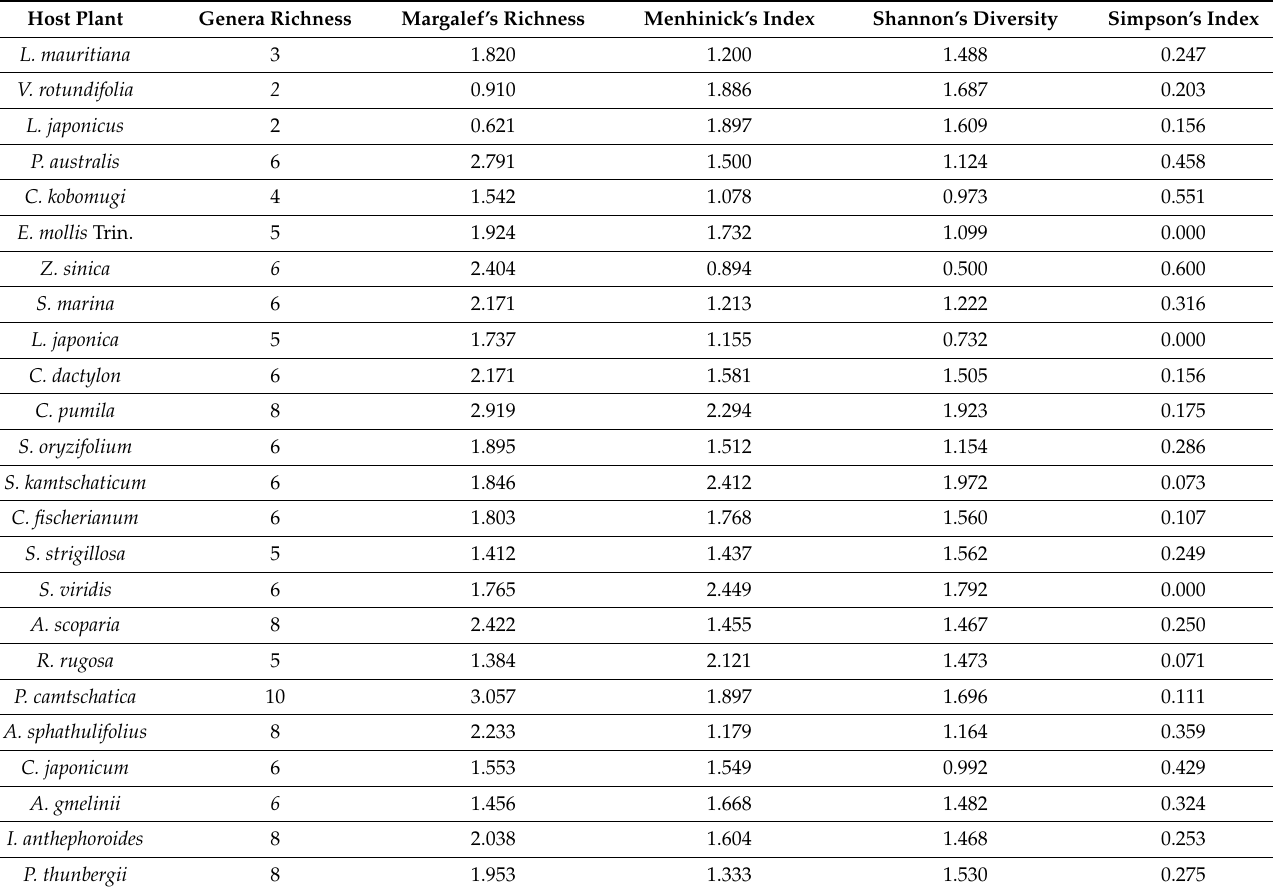
Figure 3. Morphological diversity: richness (middle), evenness (left), and ratios of dominant genera (right). Fungal richness and morphological diversity varied depending on the dominance of specific taxa. Predominance ratios were deduced to identify the genera with lower morphological diversity and abundance. Compared with other plant species, the richness of P. thunbergii was reduced by the unrivaled dominance of Talaromyces . Nevertheless, P. thunbergii had the widest morphological diversity, as more species were isolated from Taralomyces than any other fungal genera. Species diversity can be determined from the number of isolates within Talaromyces, as the strains were isolated on the basis of morphological differentiation. By contrast, Aspergillus predominated in S. marina , L. japonica , and C. dactylon , whereas Penicillium was dominant in the other host plant species. Table 3. Fungal endophyte